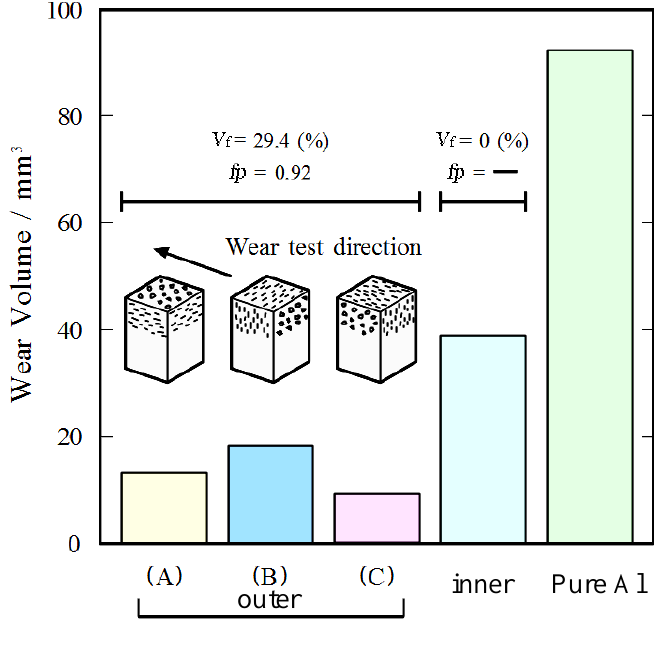
Figure 7. Wear volumes of the FGM fabricated at G = 50 [23].